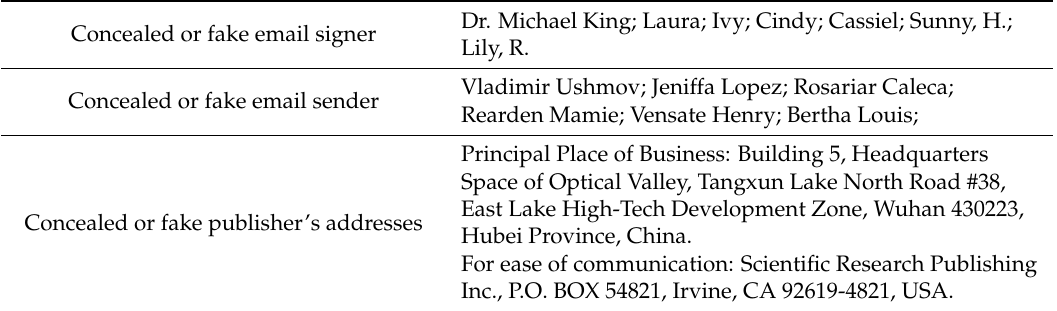
Table 2. Examples of senders’ names, aliases, and addresses in our